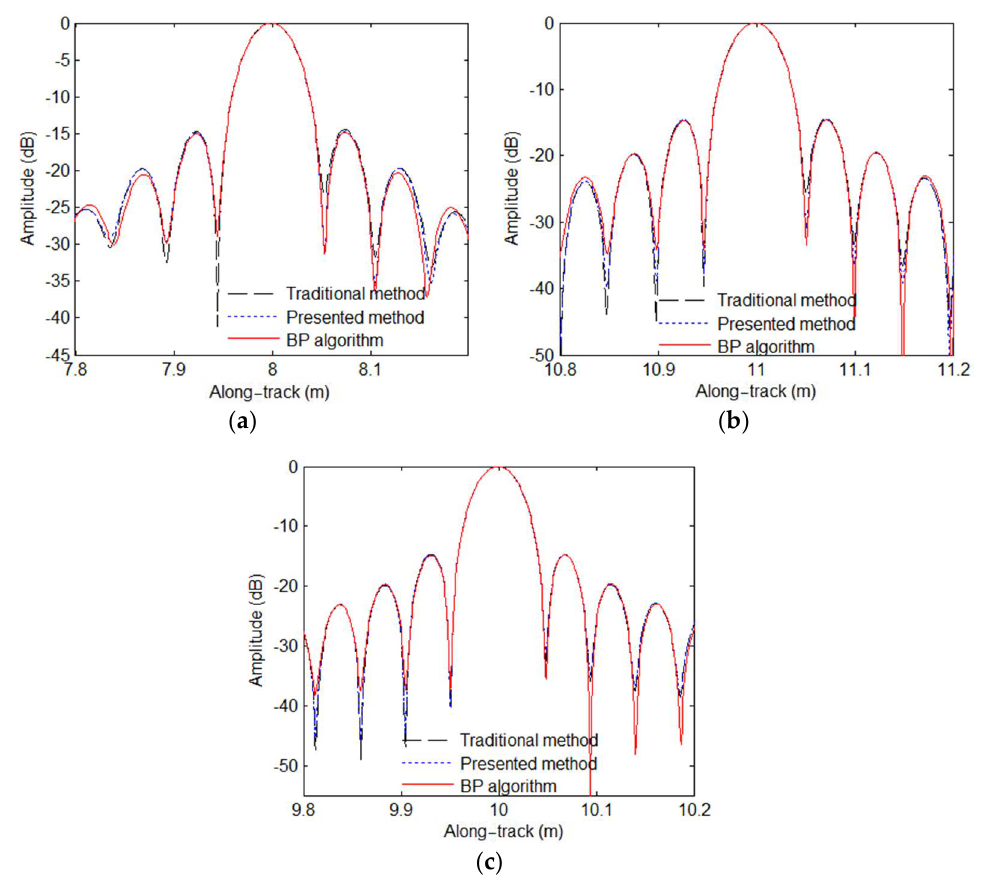
Figure 15. Along-track slices with the case of a narrow-bandwidth signal. ( a ) T1; ( b ) T2; ( c ) T3.